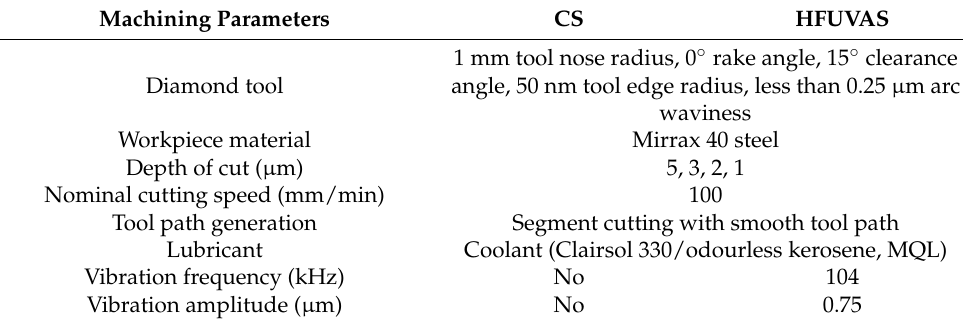
Table 1. The machining parameters of the cutting